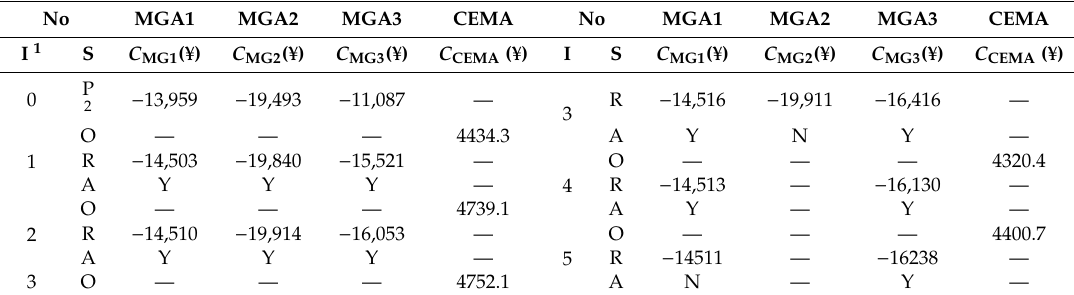
Table 6. Cost analysis during PORA.